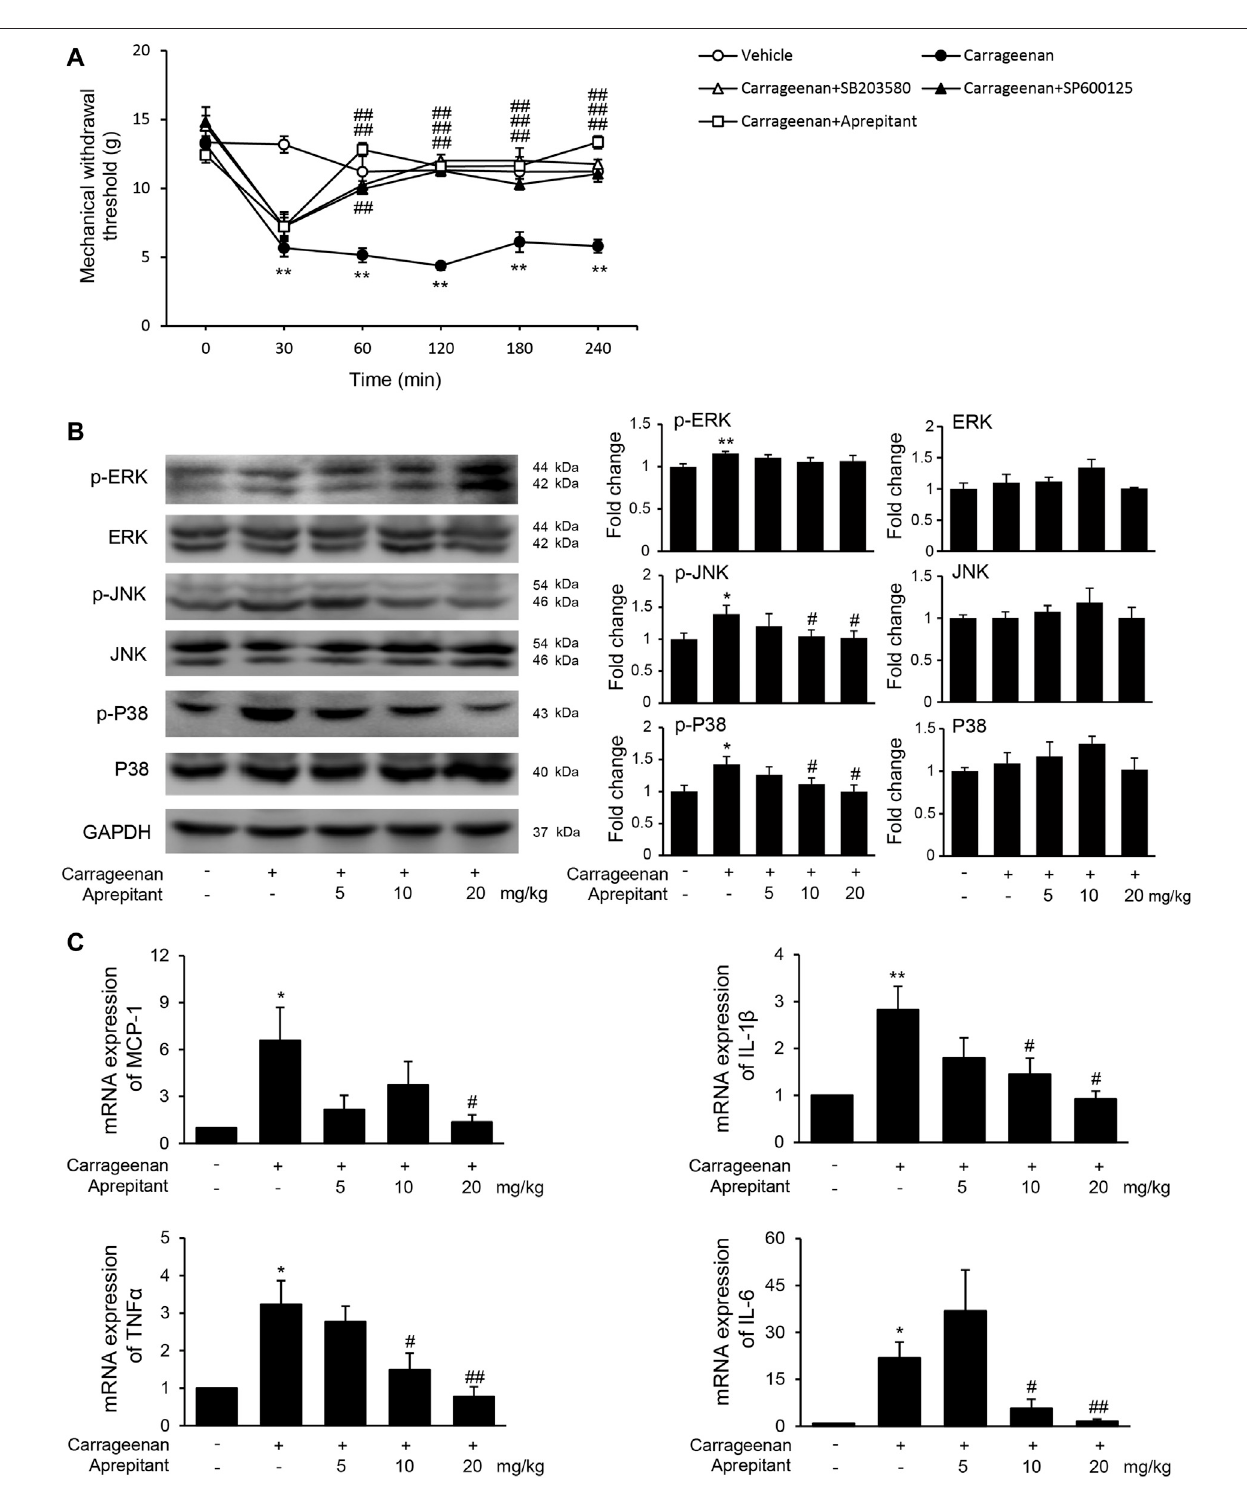
FIGURE 6 | Effect of aprepitant on carrageenan-induced mechanical allodynia and microglial activation in the spinal cord. (A) Withdrawal threshold in treatment groupsversuscontrolmice.Eleventotwelvemicewereincludedineachofthegroups.Dataareexpressedasmean ± SEM.One-wayANOVA,** p < 0.01versuscontrol, ## p < 0.01 versus carrageenan. (B) The representative immunoblots and graphic representation of relative protein and phosphorylation of ERK, JNK and p38 MAPK in spinal cord. (C) The mRNA expression of MCP-1, IL-1 β , TNF- α and IL-6 in spinal cord of mice with carrageenan-induced in fl ammatory pain ( n (cid:1) 4). Data are expressed as mean ± SEM. Two-way ANOVA, * p < 0.05, ** p < 0.01 versus control, # p < 0.05, ## p < 0.01 versus carrageenan.